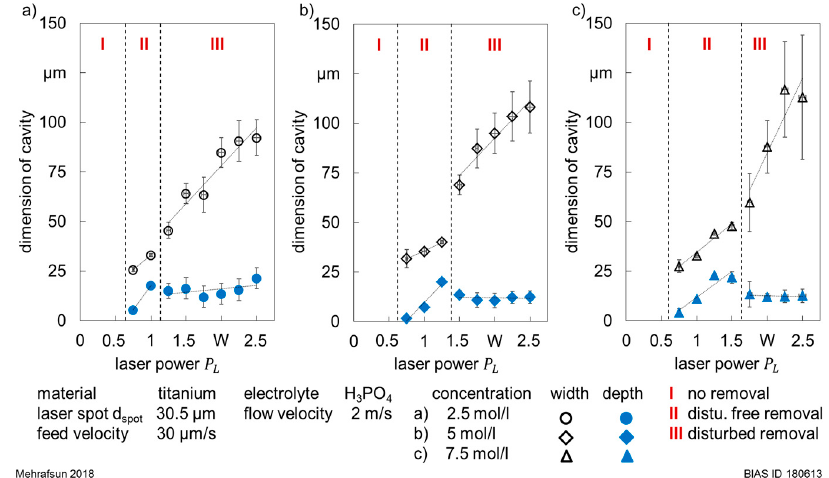
Figure 12. Width and depth of the resulting LCM cavities in titanium at a feed velocity v feed of 30 μ m/s in dependence of the applied laser power obtained at the different H 3 PO 4 solutions with concentrations of ( a ) 2.5 mol/L; ( b ) 5 mol/L and ( c ) 7.5 mol/L.